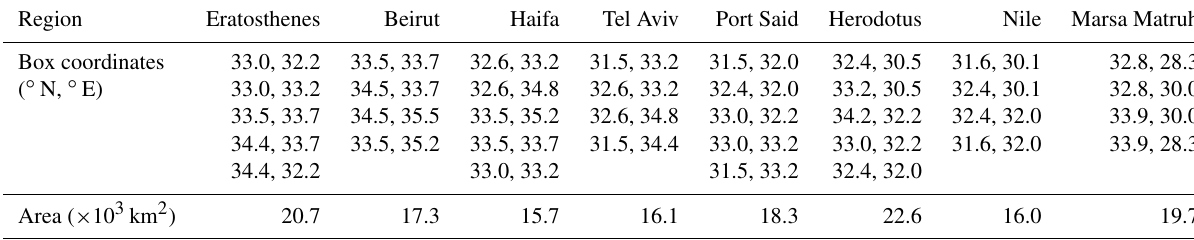
Table A1. Regions studied in the LB, showing the coordinates and area. Corresponding boxes are shown in Fig. 3. Region